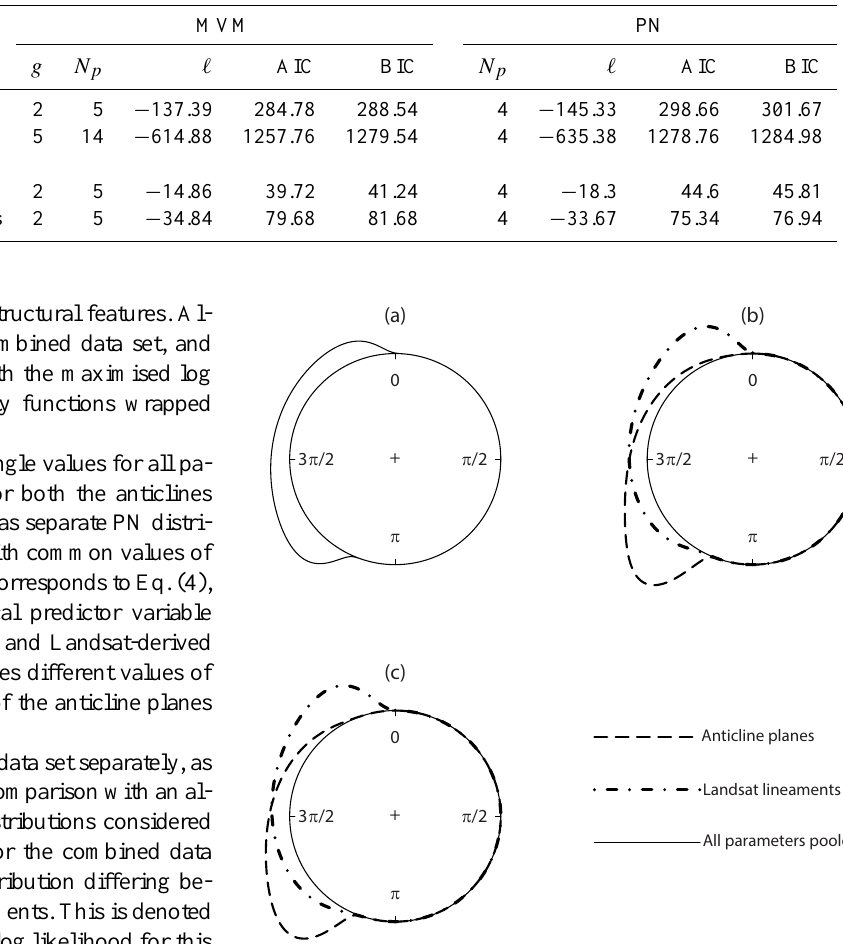
Table 3. Comparison of a mixture of von Mises (MVM) with g components and projected normal (PN) distributions.